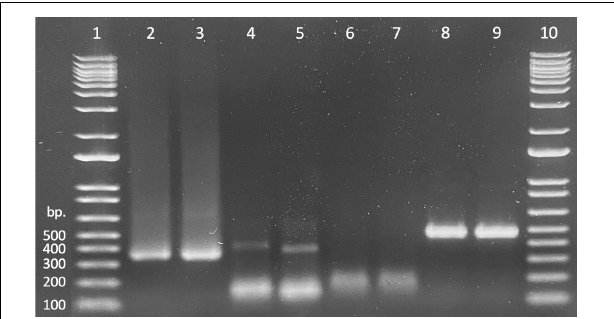
FIGURE 2 | Gel demonstrating recovery of treatment material (dsGFP, lanes 2 and 3), PCR samples amplified from dsGFP treated oak tissues using dsGFP primers (lanes 4 and 5), PCR samples amplified from water treated oak tissues using dsGFP primers (lanes 6 and 7), and samples amplified from dsGFP treated oak tissues using rps3 primers (lanes 8 and 9). Lanes 1 and 10 contain 1 Kb